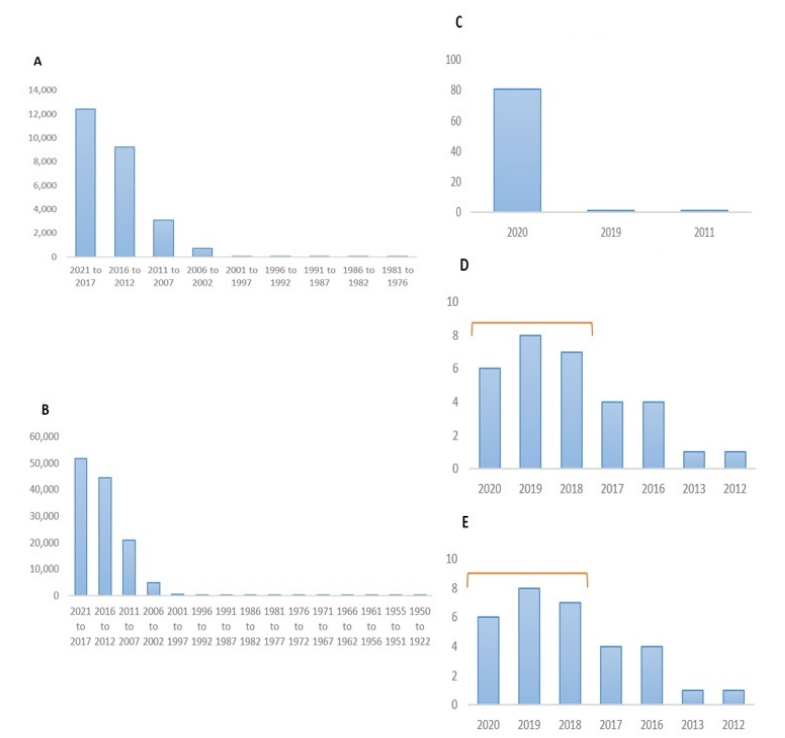
Figure 2. The published article number from the PubMed search (October 2020) vs. the years, us- ing the keywords of A : NAFLD, B ; Nano, C : MAFLD, D : NAFLD nano, E : MAFLD nano with a